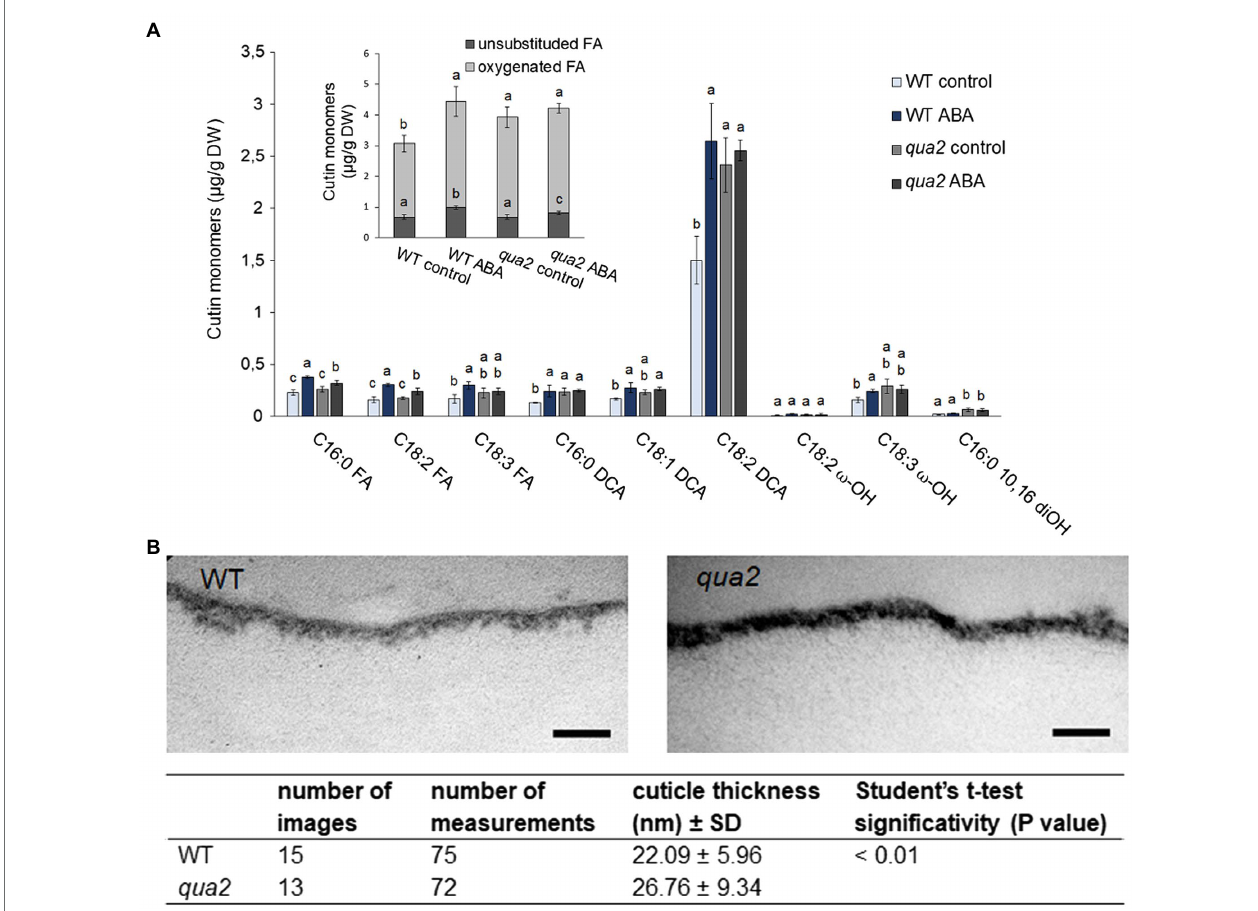
FIGURE 3 | Cutin deposition and cuticle thickness are enhanced in qua2 mutant leaves. (A) , Five-week-old plants were sprayed with 0.01% MeOH (control) or 100 μ m ABA and leaves collected after 24 h. Quantification of transesterified aliphatic and aromatic cutin monomers reveals an increase of main cutin components in qua2 which are not further increased after ABA treatment. The graph shows the analysis of the principal cutin monomers and the inset shows the sum of the indicated monomer classes per genotype and treatment. Data are mean ± SD ; n = 4 replicates. Different letters indicate significant differences as determined by ANOVA followed by Tukey’s significance test ( p < 0.05). DW, dry weight; DCA, dicarboxylic acid; ω -OH, ω -hydroxy acid; and FA, fatty acid. (B) , TEM images of the cuticle of epidermal cells of the adaxial face of rosette leaves of five-week-old WT (top panel) and qua2 (middle panel) plants. Pictures are representative of 15 (WT) and 13 ( qua2 ) images. Bars, 125 nm. Bottom panel measurement of cuticle thickness from images taken as above